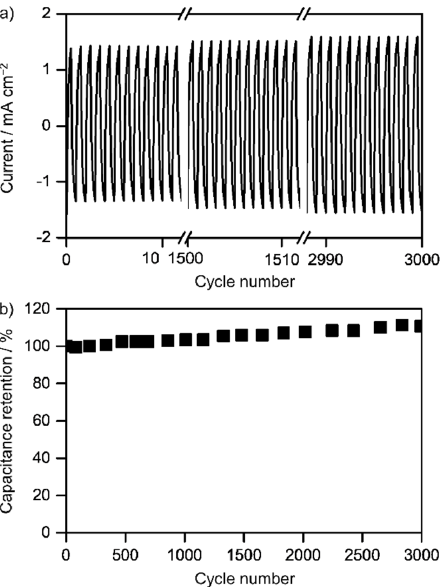
Figure 6. ( a ) Current and ( b ) capacitance retention of the Fe 3 O 4 - γ Fe 2 O 3 /rGO hybrid material as a function of the cycle number. Experimental conditions: 50 mV s − 1 , 3 M KOH solution, room temper- ature.